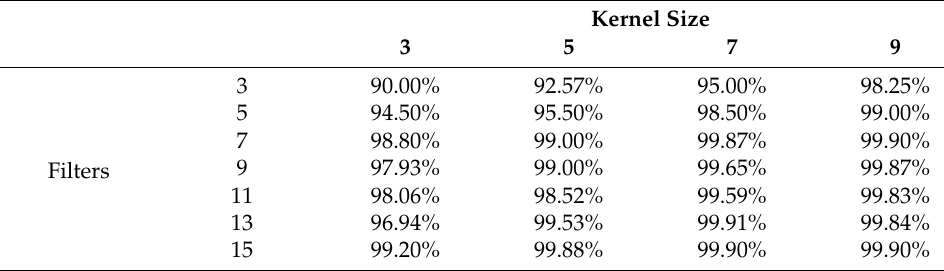
Table 1. Average training accuracy for the time delay neural network